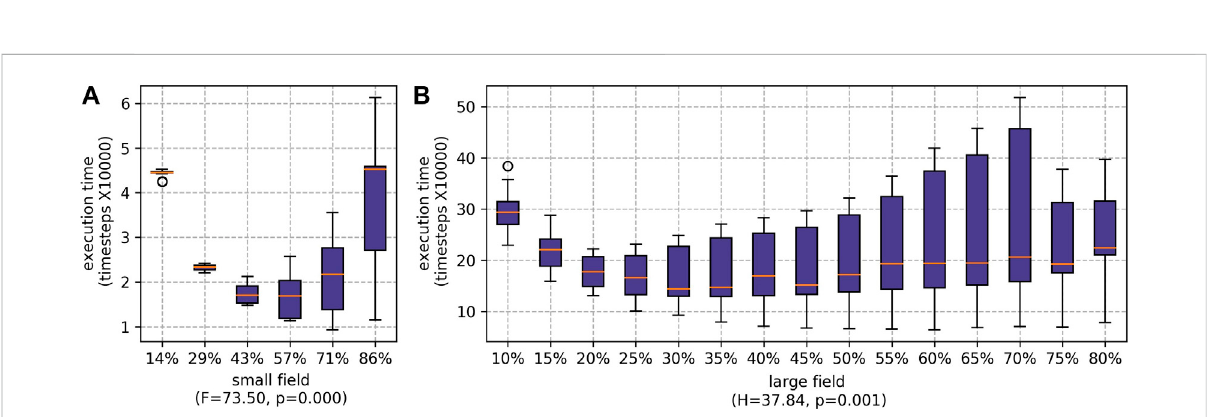
FIGURE 8 Results for execution time for different percentages of agents being employed as runners. The H statistic from Kruskal – Wallis tests and associated p values are shown, indicating statistically signi fi cant differences for the different ratios for both farms: (A) the small fi eld and (B) the large fi